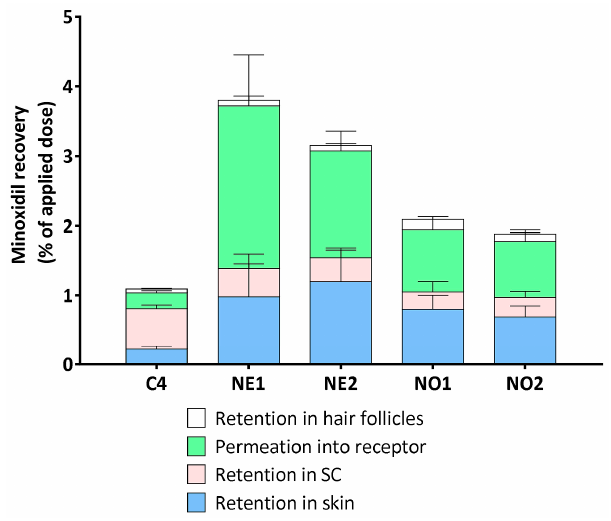
Figure 3. Minoxidil retained in the stratum corneum (SC), hair follicles, and skin layers and permeated through skin. (mean ± SD, n = 4).